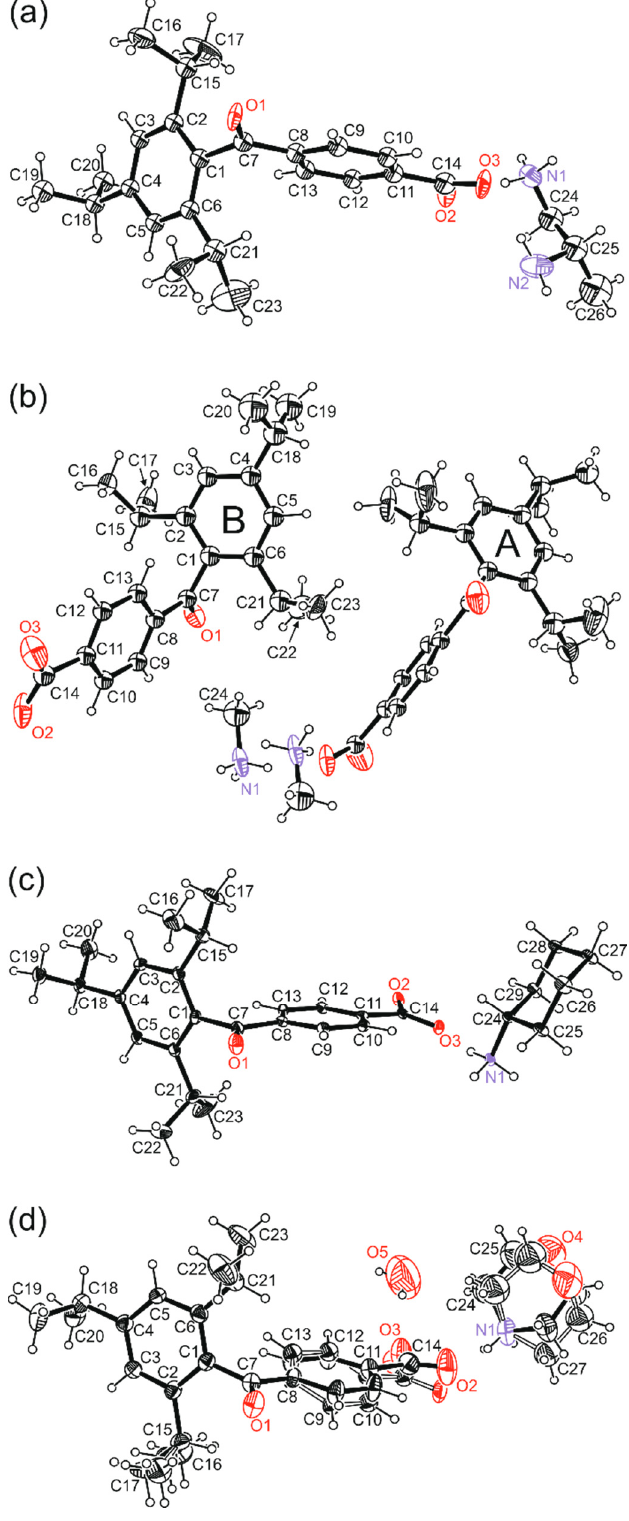
Figure 1. The Ortep view [24] for compounds ( a ) ( 1 ) at 1.3 GPa; ( b ) ( 2 ) at 1.0 GPa; ( c ) ( 3 ) at 0.1 MPa; and ( d ) ( 4 ) at 0.1 MPa. The displacement parameters of non-hydrogen atoms were drawn at a 30% probability level. The atoms of the minor component of ( 4 ) were connected by empty bonds.